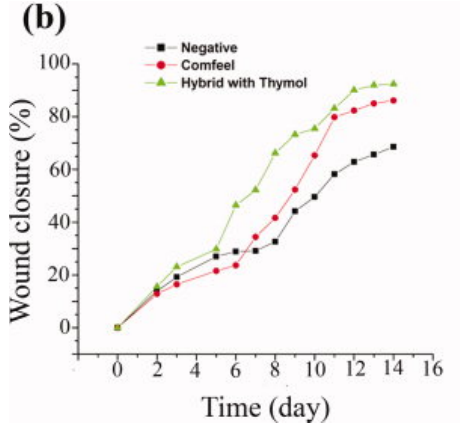
Figure 7. ( a ) Photographs obtained from wounds covered with (A) gauze, (B) Comfeel